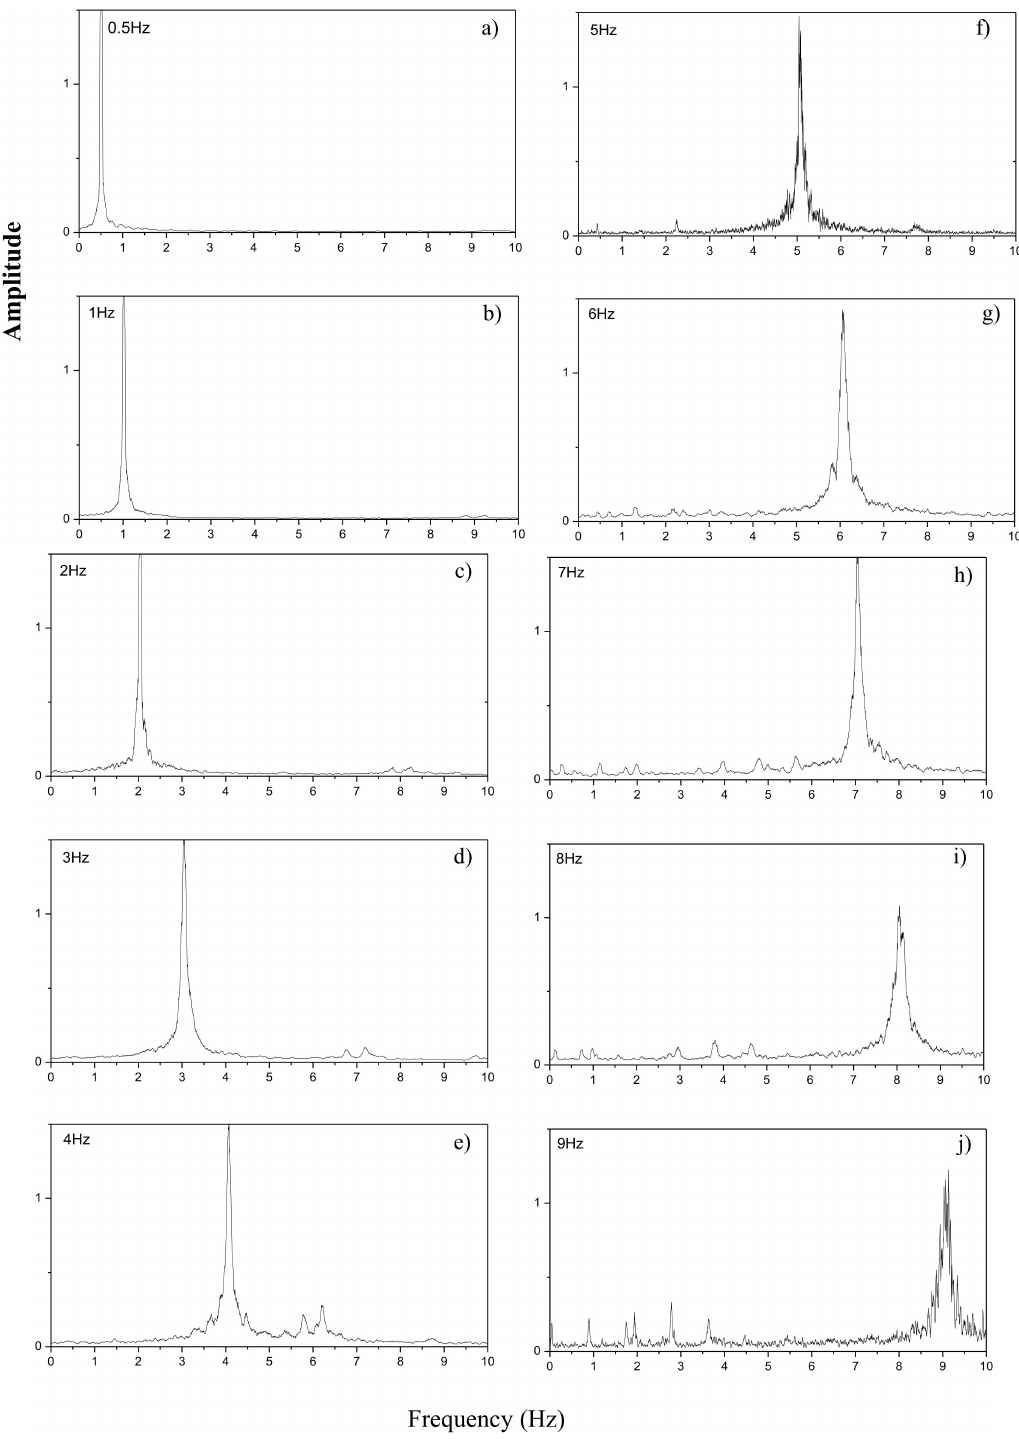
Figure 9. Principal frequency diagram of spectral analysis of different segments. ( a ) Frequency diagram of 0.5 Hz; ( b ) frequency diagram of 1 Hz; ( c ) frequency diagram of 2 Hz; ( d ) frequency diagram of 3 Hz. As showed in Figures ( a – d ), the frequency curve is very smooth, there are no obvious small-peak amplitudes; ( e ) frequency diagram of 4 Hz; ( f ) frequency diagram of 5 Hz; ( g ) frequency diagram of 6 Hz; ( h ) frequency diagram of 7 Hz; ( i ) frequency diagram of 8 Hz. In ( e – i ), the growth of small-peak amplitudes more and more with the increase of sampling rate. That reflects the reduction of the signal-to-noise ratio in the observations; ( j ) frequency diagram of 9 Hz. Though the principal frequency could be acquired, but the signal had become